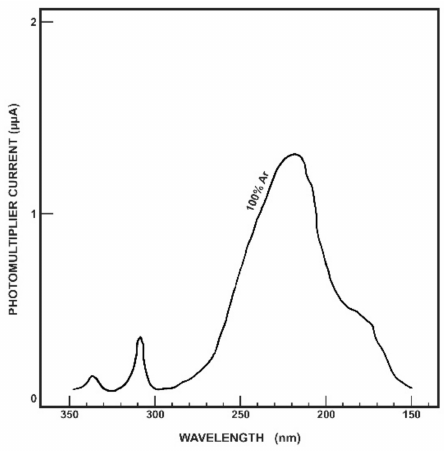
Figure 1. Radioluminescence spectrum of 100% argon. Figure reproduced from